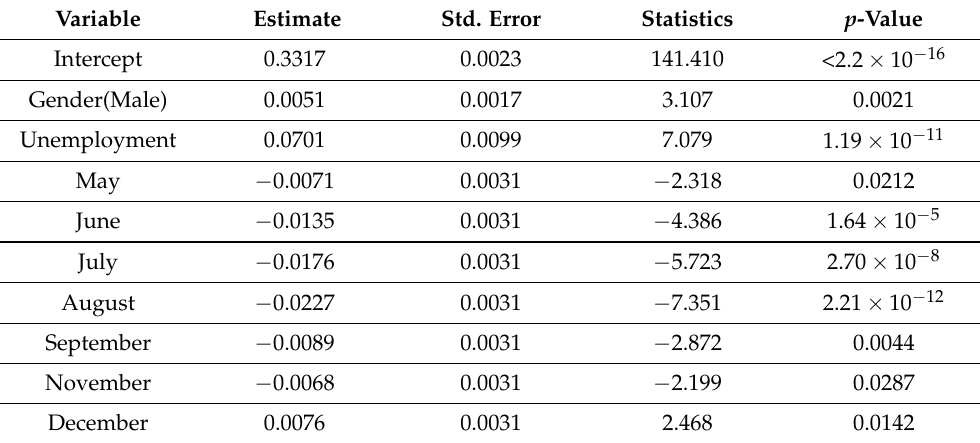
Table 3. Linear regression of the Gini coefficient for the age group up to 24